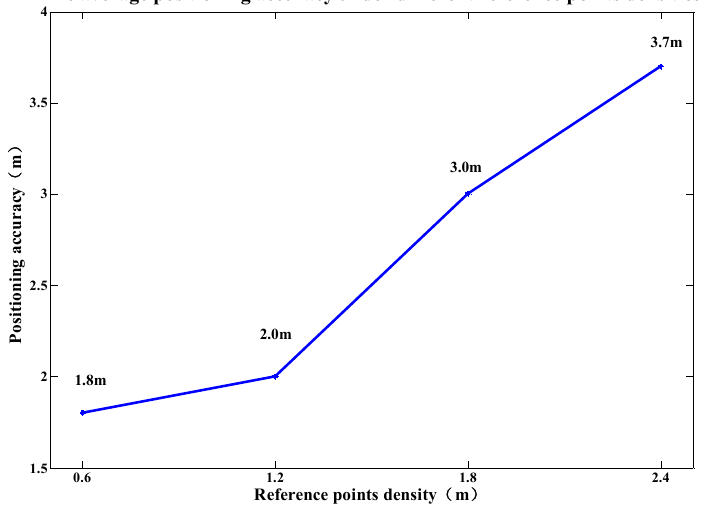
Figure 17. The average positioning accuracy under different reference point densities.